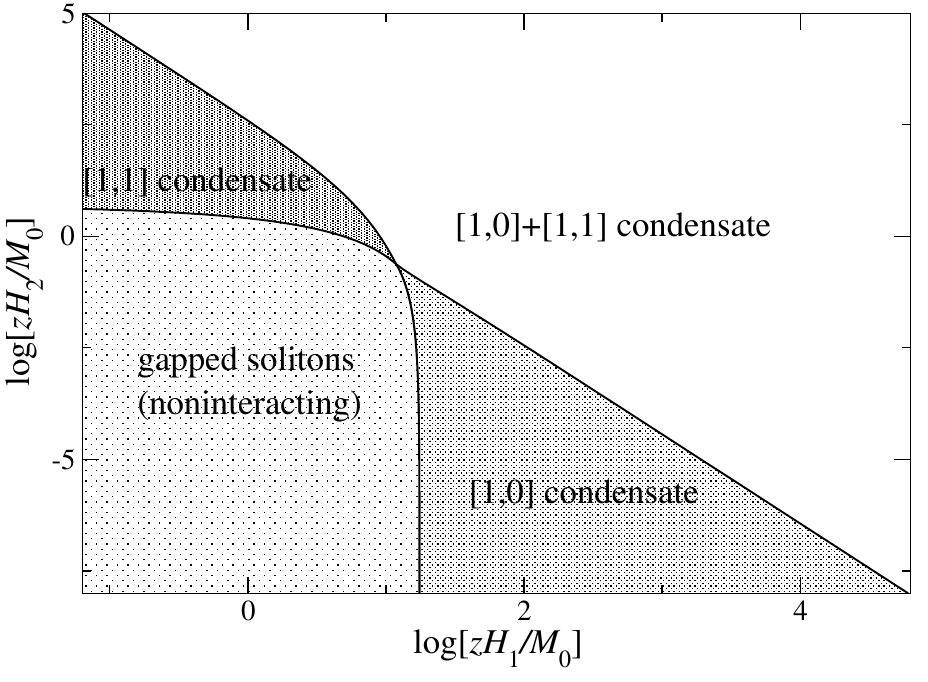
Figure 2 . Zero temperature phase diagram of the model (1.1: as the (cid:12)elds H 1 ; 2 are increased solitons carrying quantum numbers of the highest weight states in the [1 ; 0] vector and the [1 ; 1] spinor representation of SO(5) condense (the actual location of the phase boundaries is obtained from the numerical solution of the TBA equations (2.12) for T = 0 and p 0 = 2 + 1 = 3). where (cid:15) (1)